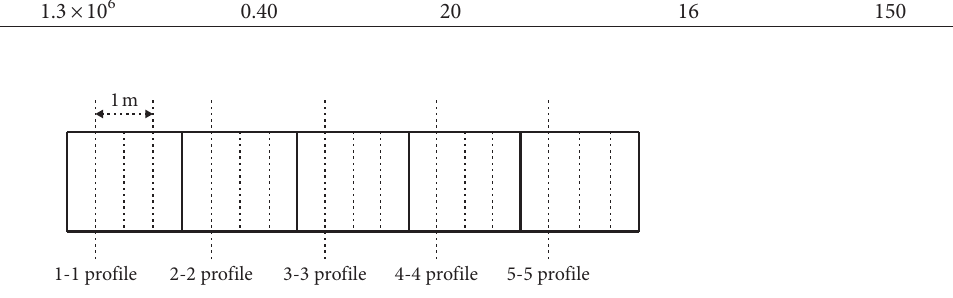
Figure 4: Schematic diagram of 1m excavation